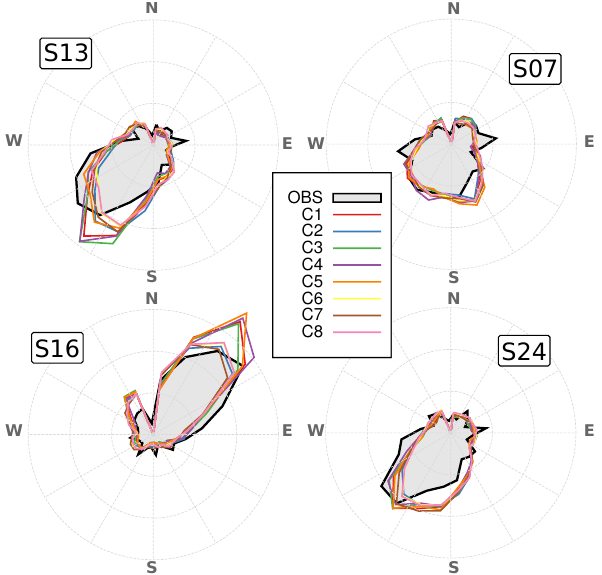
Figure 6. Wind roses corresponding to four different storm cases selected from Table 2. The number of the case is indicated in each panel, and corresponds to storm Lothar (S13), as well as three other storms with different synoptic conditions. The colours correspond to observations and simulations as in Fig. 4. For the calculation of the histograms, the hourly wind direction during the entire period registered in each location is pooled, and the number of times that a wind direction lies within each 15 ◦ bin is counted and finally nor-